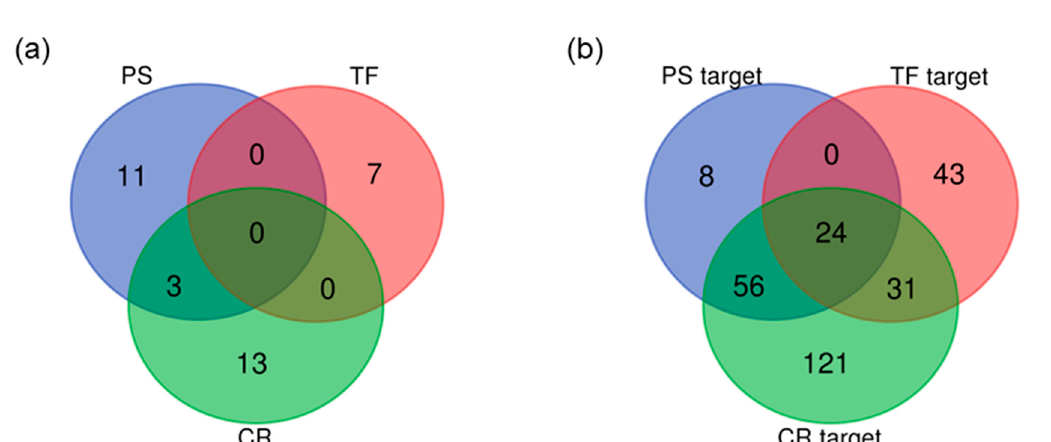
Figure 1. ( a ) Venn diagram showing the distribution of potent active compounds in SCH derived from the three constituent herbs; ( b ) Venn diagram showing all targets of each constituent contained in SCH. Data were obtained from the TCMSP